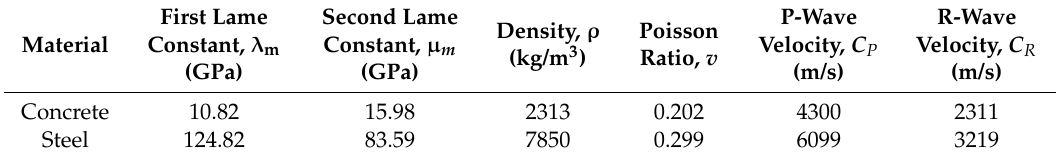
Table 1. Mechanical properties of the model materials obtained from experimental measurements.